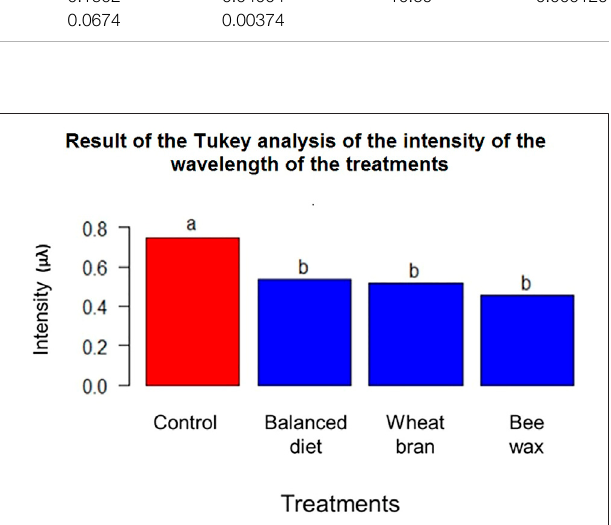
FIGURE2| Interaction between treatment time and beekeepingresidue in the rearing of G. mellonella .